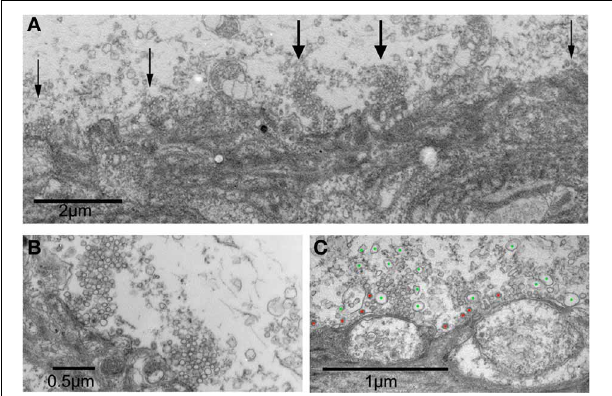
FIGURE 8 | Electronmicrographs of a synaptic junctions following RNS60 ASW superfusion. (A) Presynaptic and postsynaptic image at low magnification showing postsynaptic digit making several contacts forming active zones with the presynaptic terminal (arrows) in a synapse superfused with control ASW. (B) Higher power image showing two active zones from panel (A) that are marked with wide arrows. (C) Vesicles of irregular shapes and sizes are present in the terminals from a synapse superfused with RNS60 ASW. Green dots denote large synaptic-like vesicles, red dots mark clathrin-coated vesicles.